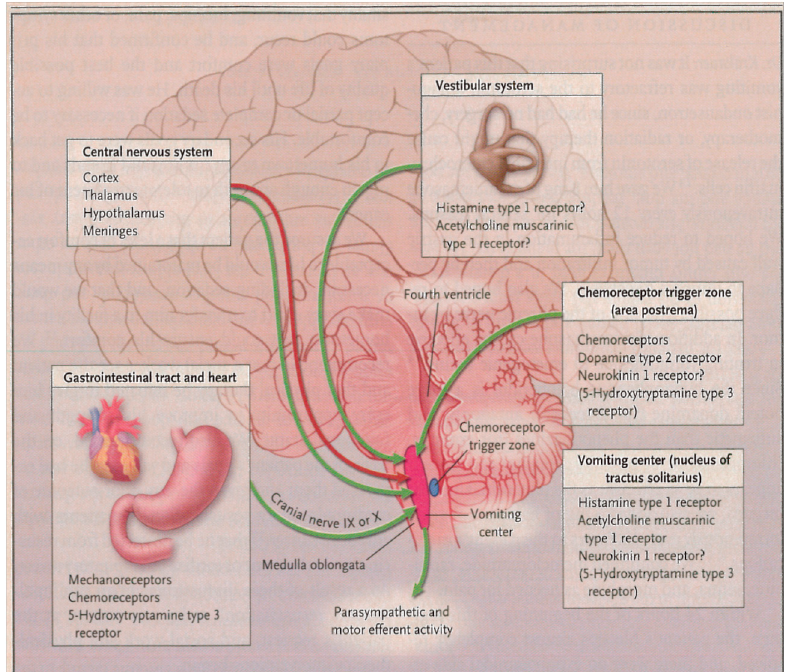
Figure 1. Schematic representation of proposed neural pathways that mediate vomiting. 5-HT: 5- hydroxytryptamine; GI: gastrointestinal. Reprinted from [23]. Copyright 2016, with permission from Elsevier.